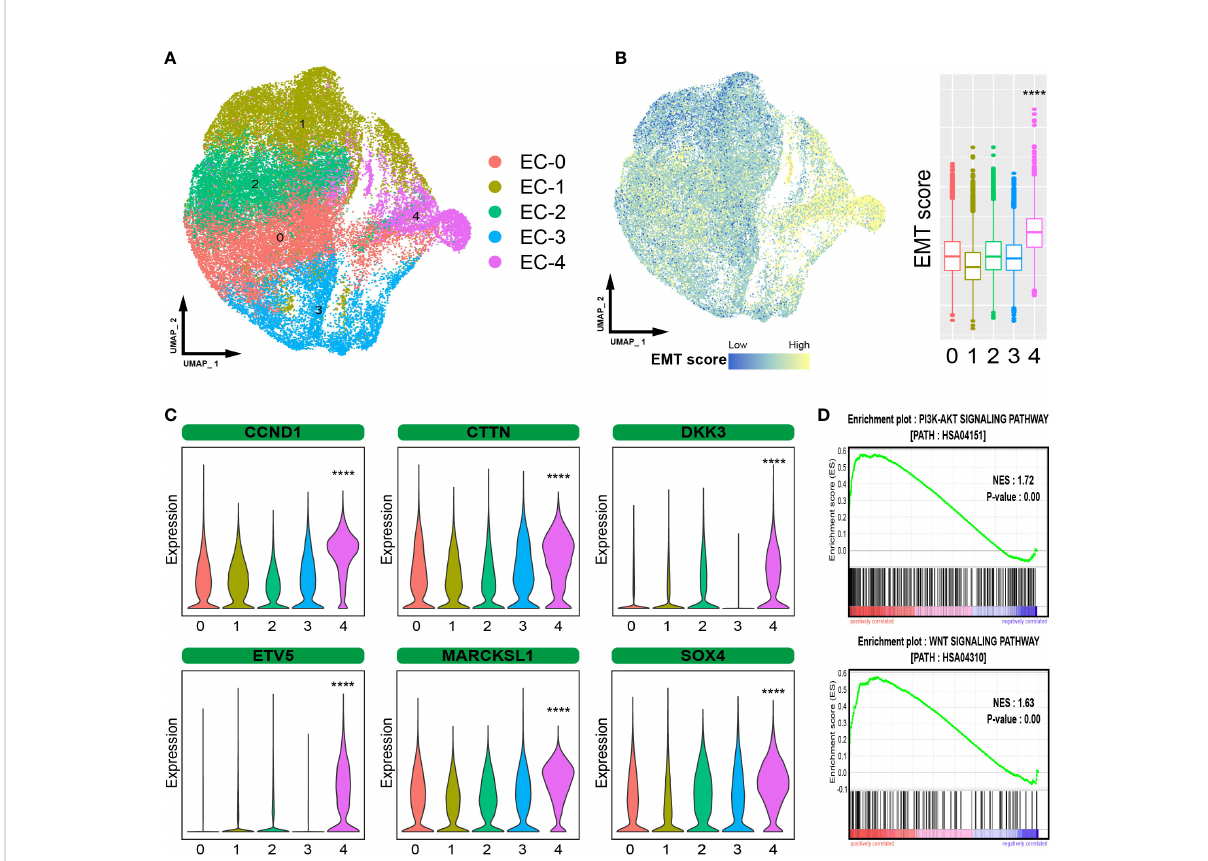
FIGURE 2 Heterogeneous analysis of malignant epithelial cells. (A) . UMAP plot showing the subpopulations of epithelial cells. (B) . EMT levels of epithelial cells. (C) . Violin plot showing the expression of certain metastasis-related genes. (D) . GSEA showing that the pathways activated in EC-4 cells. The symbol **** represent p-values less than